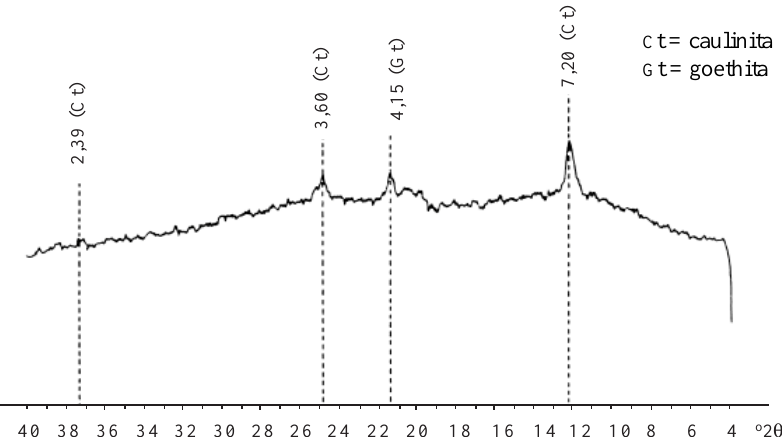
Figura 7. Difratograma de raios X do material em suspensão na solução de solo sob pastagem.